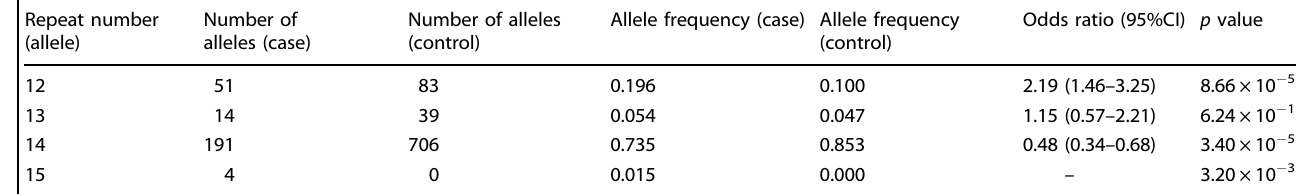
Table 1. Association of single nucleotide repeats on CDH12 gene.